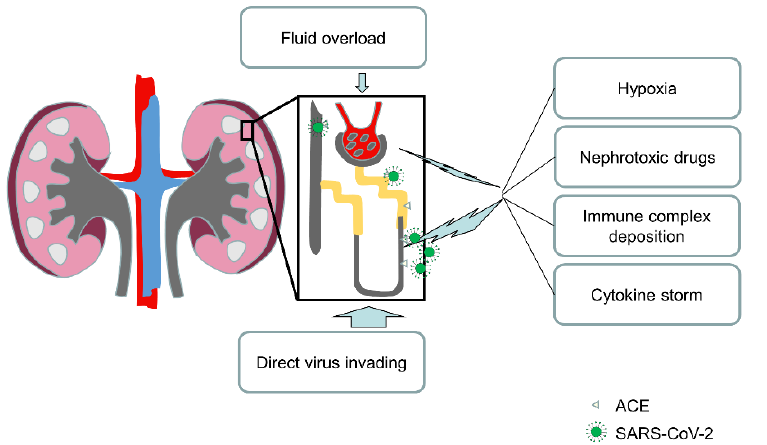
Figure 4. Potential mechanisms of kidney impairment in COVID-19 patients. SARS-CoV-2 can directly invade renal tubular epithelial cells via ACE2, a virus-specific receptor that is mainly ex- pressed in proximal tubular cells, which potentially leads to host cell damage and death. At the same time, nephrotoxic drugs, hypoxia, and infectious induced extensive immune activation featured by cytokine storm and immune complex formation were also factors related to tubular cell impairment. The impairment caused by compromise of tubular integrity may be major reason for the occurrence of an abnormal urinalysis. In addition, although there were no significant signs of kidney dysfunction and acute kidney injury characterized by increased Scr, BUN, and cystatin C, many known factors may provoke injury to the glomeruli, such as inflammation, nephrotoxic drugs, and fluid overload.